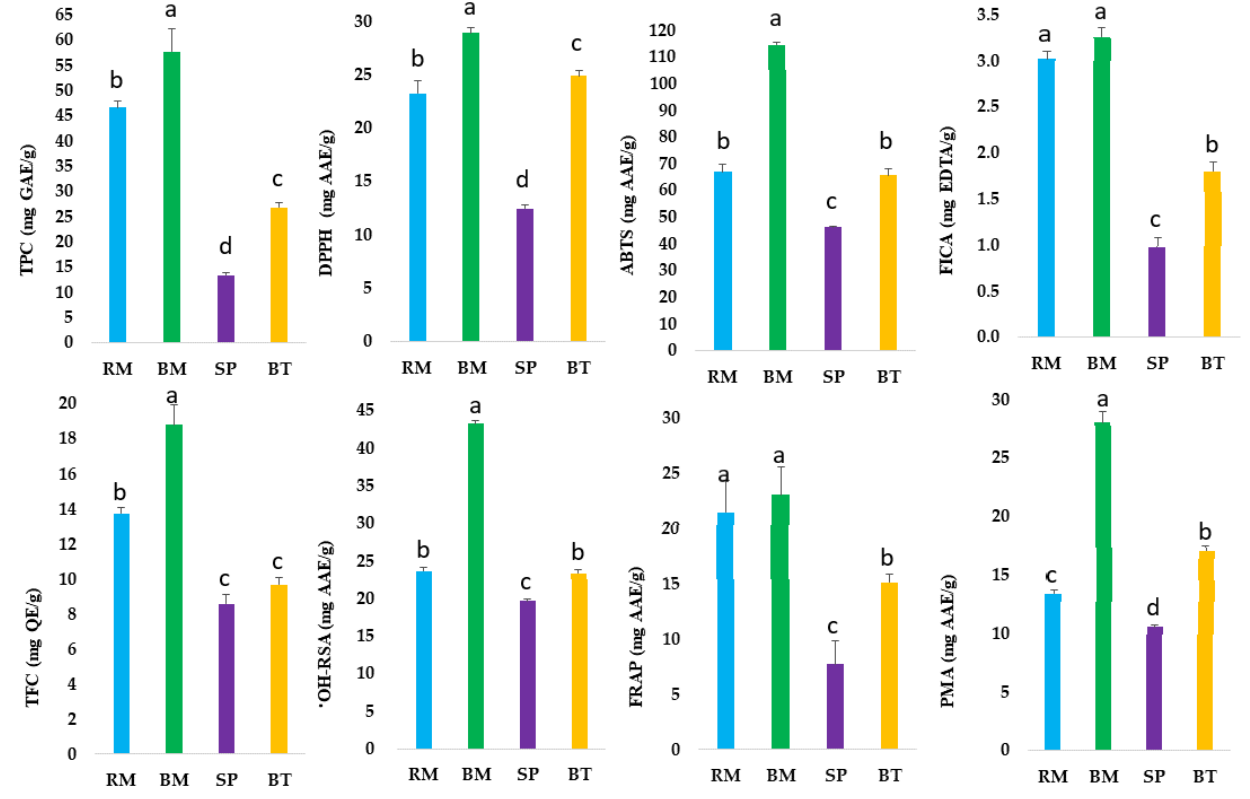
Figure 1. Phenolic contents (TPC and TFC) and antioxidant activities of river mint (RM), bush mint (BM), sea parsley (SP), and bush tomatoes (BT). The vales with letters (a–d) are significantly different from each other.